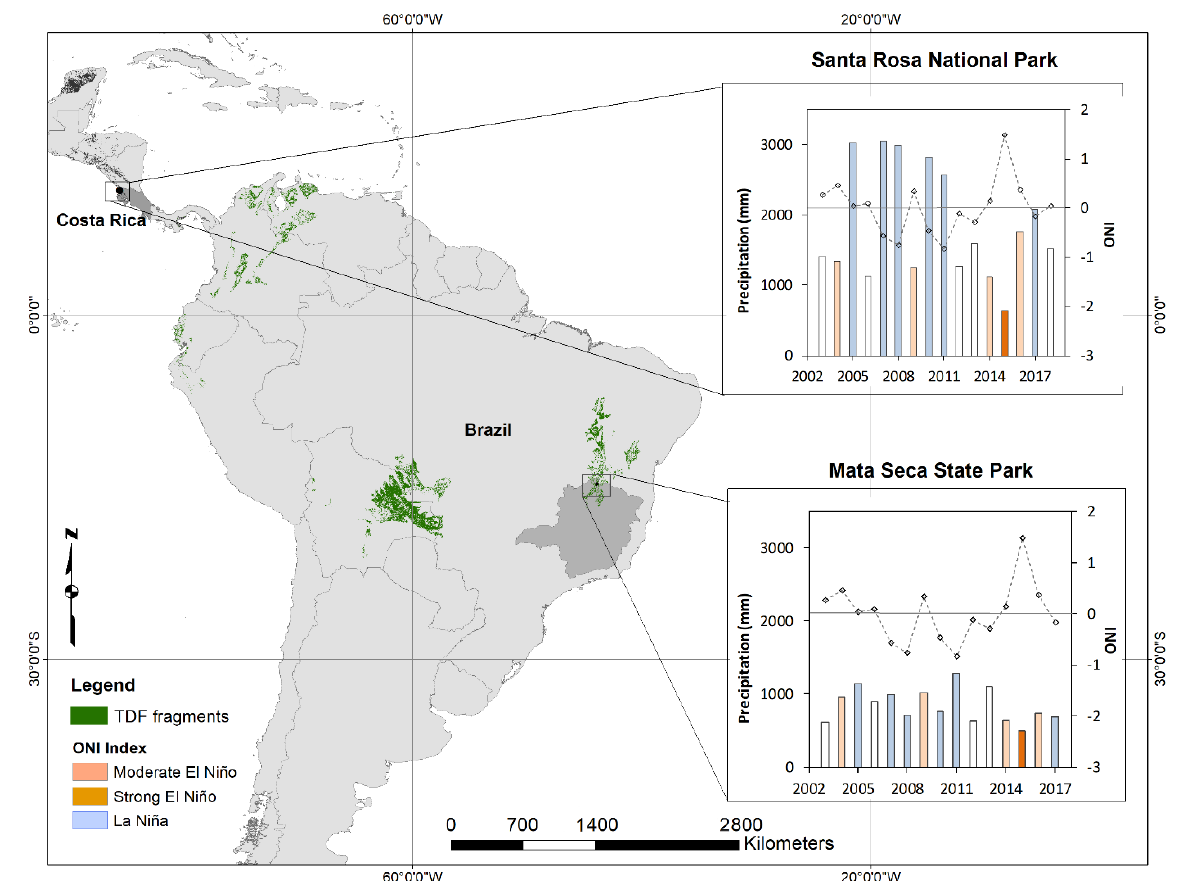
Figure 1. Location of tropical dry forests (TDFs) used in this study with insets of temporal variability of precipitation in bars and the Oceanic Nino Index (ONI) for 2003–2018 for Santa Rosa National Park Environmental Monitoring Super Site (SRNP) and 2003–2017 for Mata Seca State Park (MSSP). Orange bars represent years for “El Niño” occurrence ((ONI > 0.5), less precipitation) and blue bars for “La Niña” occurrence ((ONI < − 0.5), increased precipitation), according to the National Oceanic and Atmospheric Administration (NOAA).